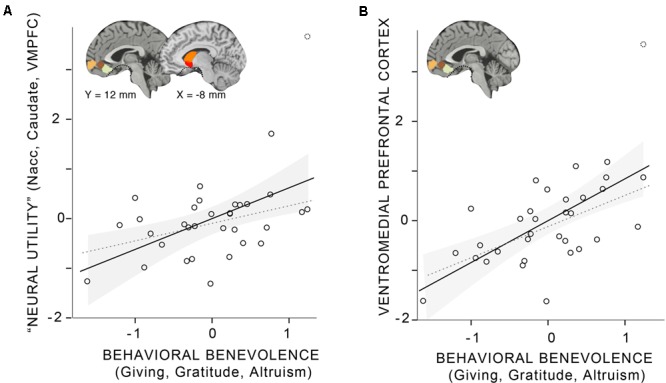
Linear relationship between the behavioral benevolence aggregate and aggregates for neural pure altruism in seven a priori regions of interest (ROIs) implicated in previous research (Hubbard et al., 2016). The insets show the locations of the ROIs: ventromedial prefrontal cortex (VMPFC) ROIs are those reported in Clithero and Rangel (2014). Subcortical ROIs [left and right nucleus accuments (Nacc), left and right Caudate] are Harvard Oxford atlas locations thresholded at 30%. The dashed line in ventral regions of the brain shows the limit of our sampling of the brain due to magnetic susceptibility artifacts. (A) The “neural utility” aggregate that includes all seven ROIs. (B) The aggregate across VMPFC ROI. For both panels, the shaded gray area represents the 95% confidence interval of the mean. The solid line represents the linear estimate with all participants included. The gray dashed line represents the estimate without a participant that was a potential outlier (> 3 SDs from the mean).